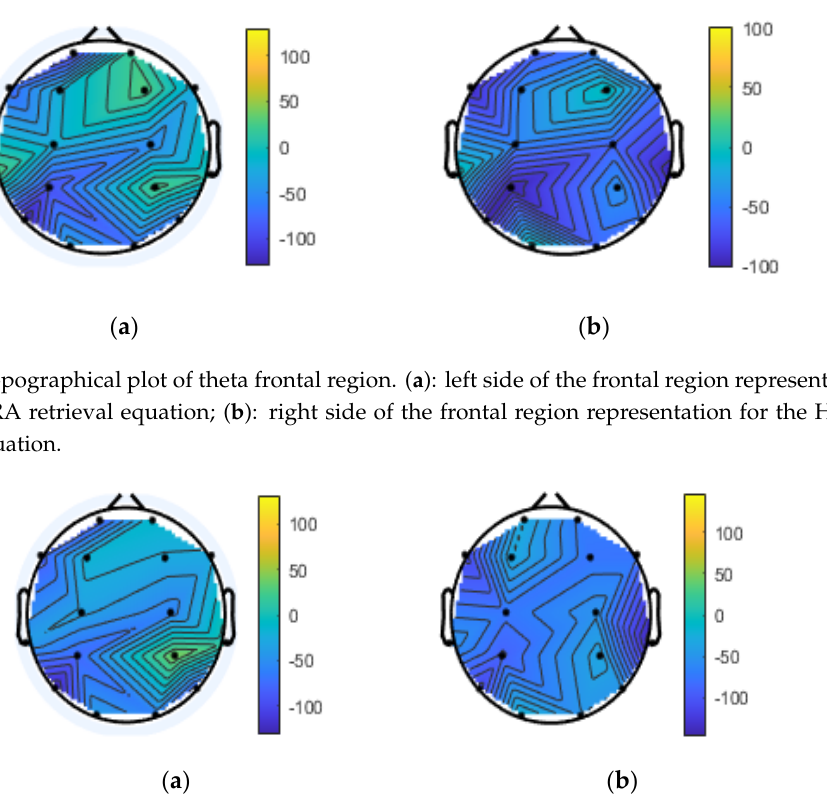
Figure 4. Topographical plot of delta frontal region. ( a ): left side of frontal region representation for the HERA retrieval equation; ( b ): right side of the frontal region representation for the HERA retrieval equation.